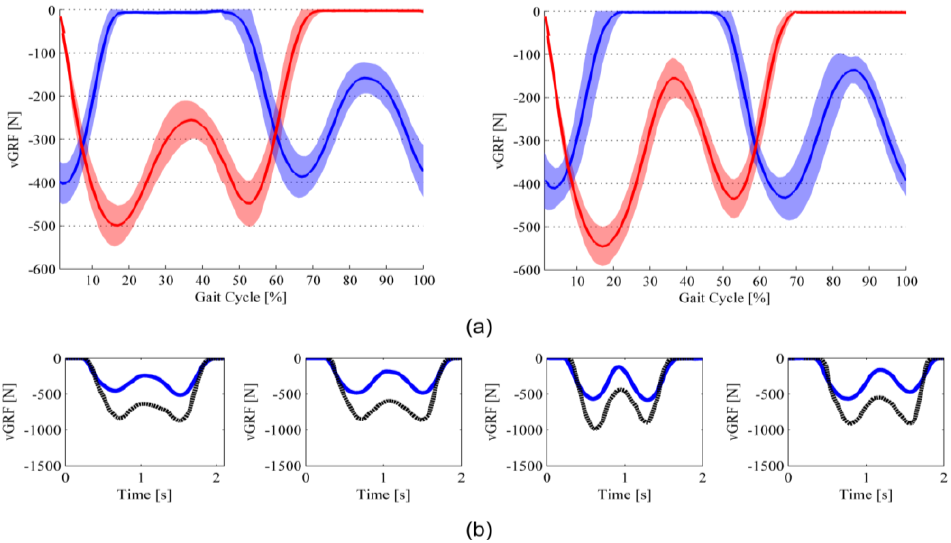
is on average equal to 0.03 s. Figure 8. profiles of Subject #1. Red line is the left foot; blue line is the right foot. ( a ) Average curve during slow- (on the left panel) and normal- (on the right panel) speed ground-level walking; ( b ) Comparison between the profile measured through the sensorized insole (solid blue line) and the force platform (dotted black line) in four different